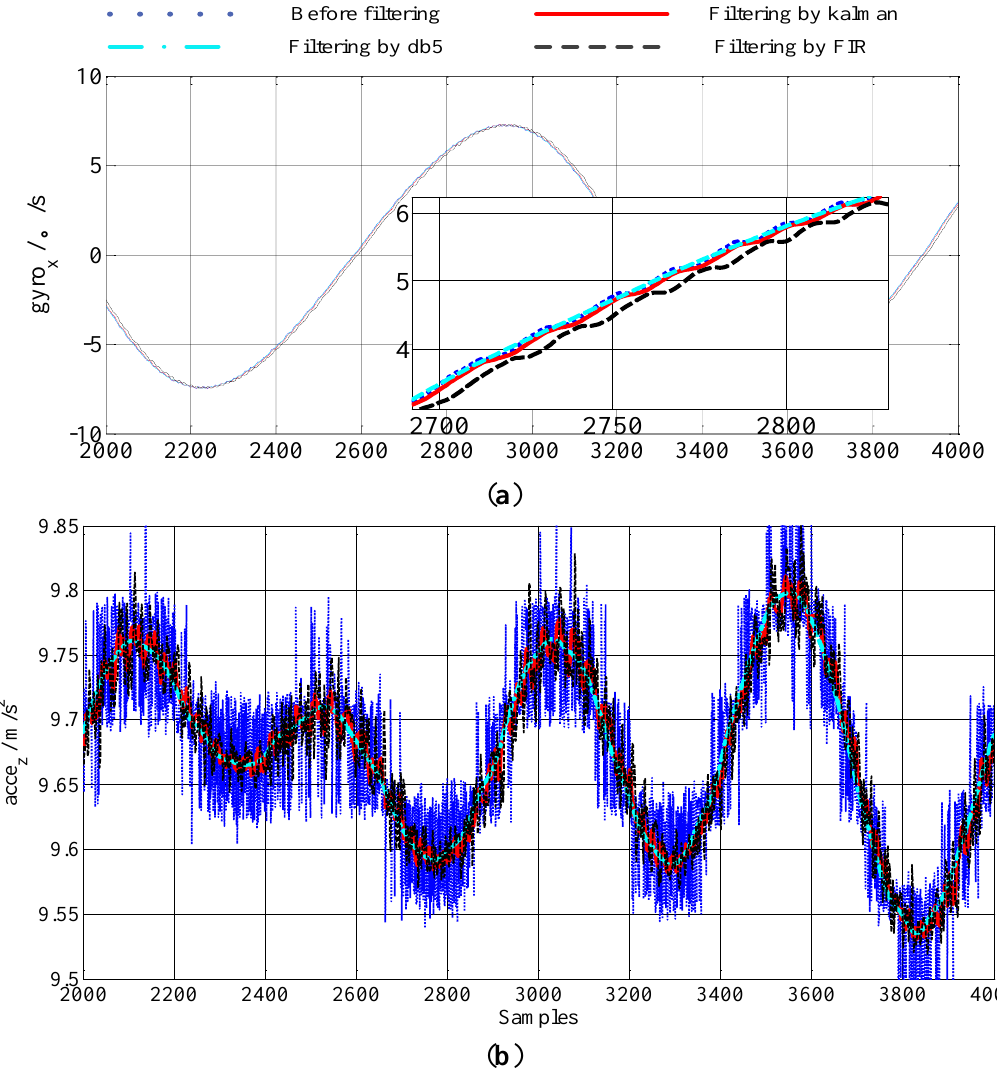
Figure 9. IMU data in swinging ( a ) gyro dates ( b ) accelerometer